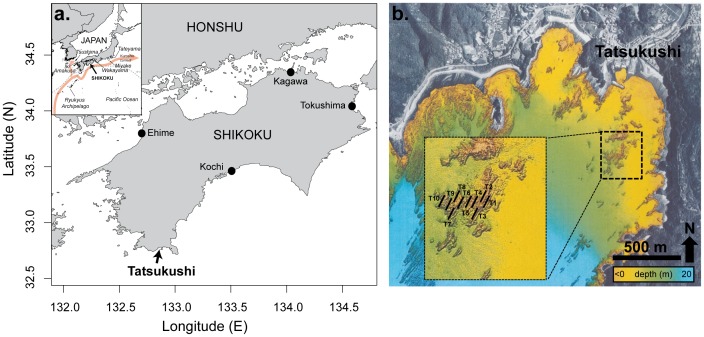
Study site. a.Location of Tatsukushi at Shikoku Island (Japan). b. Local geographic features of Tatsukushi Bay with the area survey and approximate locations of transects. Color scale corresponds to bathymetry obtained by sonar exploration [25].